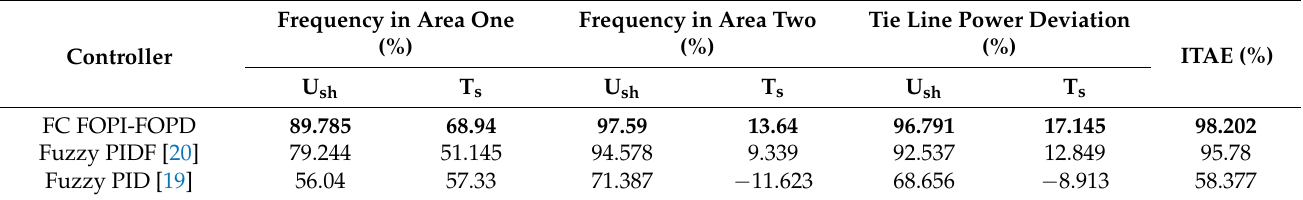
Figure 7. Percentage of betterment with different controllers. Table 6. Percentage of improvement in dynamic characteristics based on different strategies.